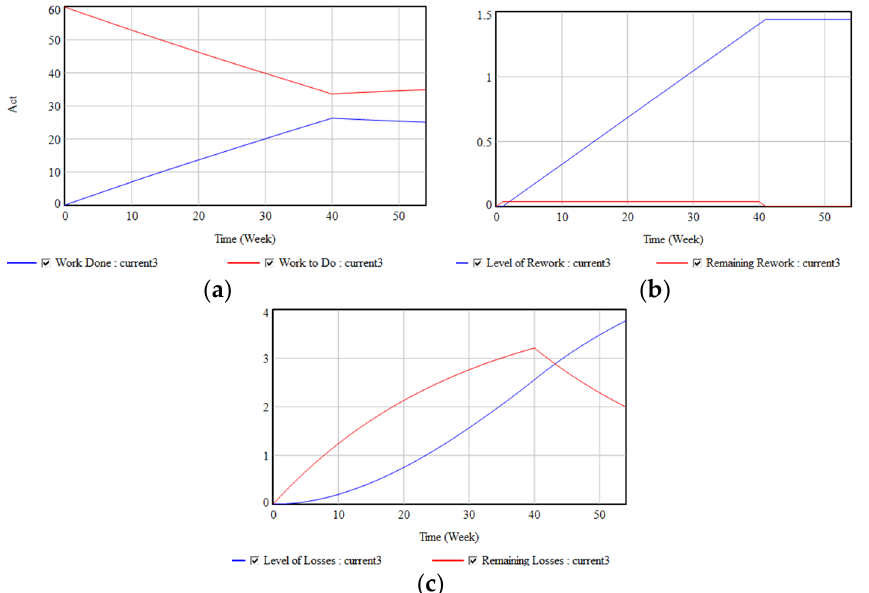
Figure 4. ( a ) Simulation results for 𝑉 (cid:2870)(cid:2869) : Work Done and Work to Do ; ( b ) Simulation results for 𝑉 (cid:2870)(cid:2869) : Level of Rework and Remaining Rework ; ( c ) Simulation results for 𝑉 (cid:2870) (cid:2869) : Level of Losses and Remaining Losses .